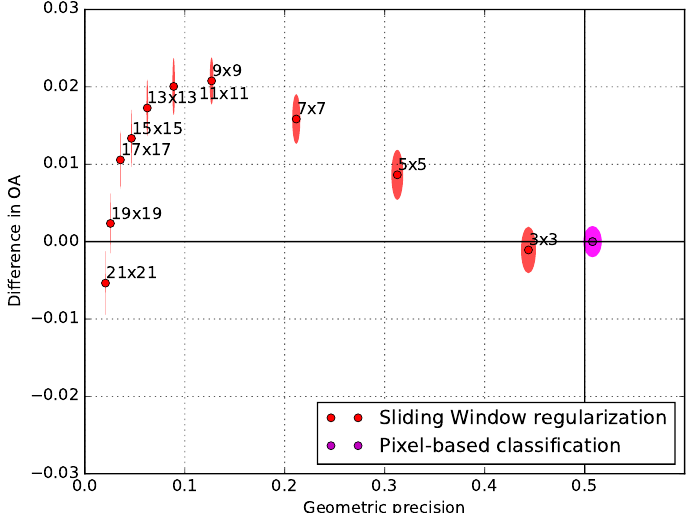
Figure 5. Impact of the sliding window majority vote regularization on the Overall Accuracy and geometric precision (PBCM). Each pixel is assigned the majority label in the sliding window. The size of the filter, in pixels, is shown next to the points. This kind of regularization increases the statistical classification scores, however, the image of the result shows that the corners are strongly smoothed out. This is confirmed by the PBCM metric. The axes of the ellipses show the standard deviation of both the Overall Accuracy and the PBCM, over the 10 runs with different subsets of training